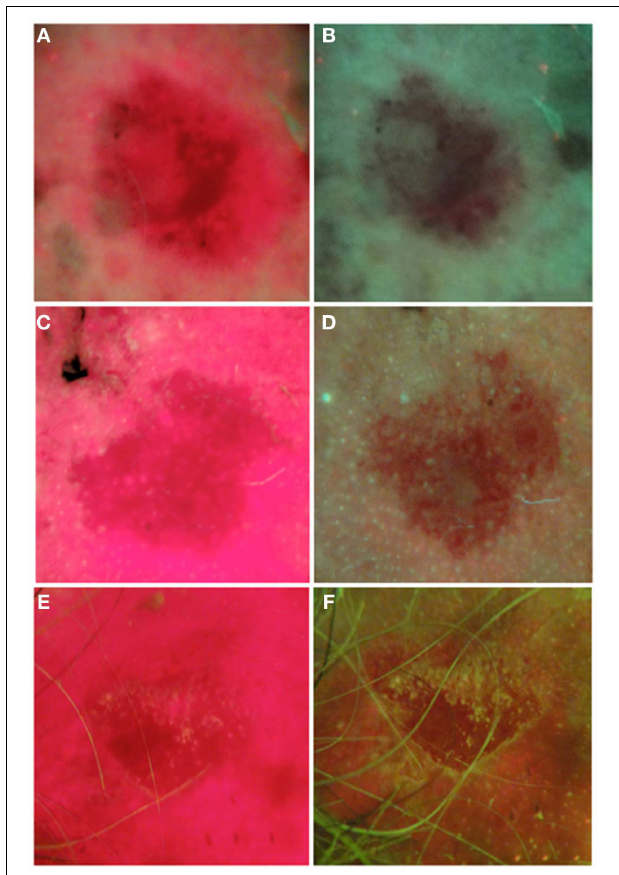
FIGURE 3 | PpIX fluorescence images of BCC lesions before 3h of MAL topical application (A,C,E) and after the second PDT session (B,D,F).